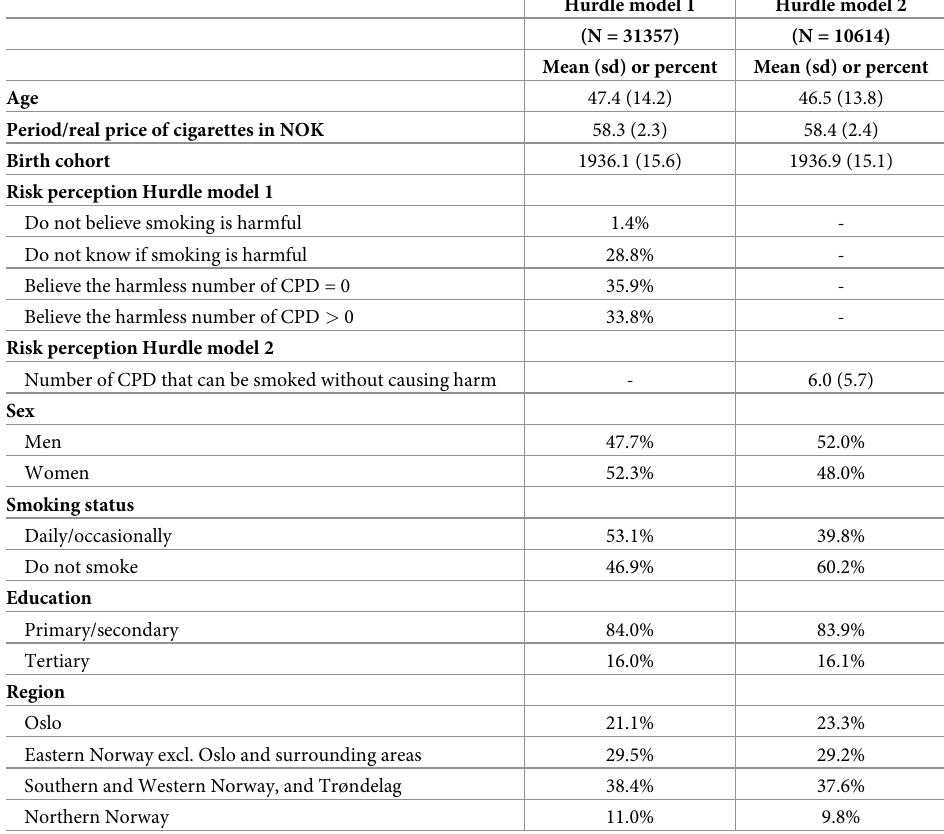
Table 1. Descriptive statistics and variable description for hurdle model 1 and 2, men and women from 25 to 74 years, 1973 to